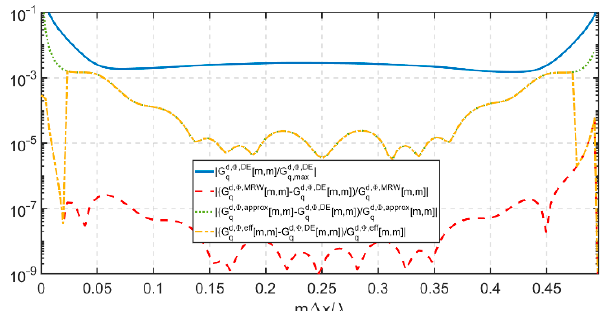
Figure 2. The solid line stands for values of the magnitude of G qd, Φ [m,m] normalized to maximum value computed by DE formulas. The dotted lines and dashed lines stand for the relative error of the values G qd, Φ [m,m] obtained by approximation given in Equation (28) and MRW quadrature rules with respect to the values obtained by DE formulas. The dash dotted lines stand for relative error for m = n obtained by mixed rules (MRW quadrature rules when m ∆ x / λ < 0.02 or (m ∆ x-a) / λ < 0.02, and approximation given in Equation (28) for the rest of the cases). We can see that the error level obtained by MRW quadrature rules is lower than 0.03% for the worst case (m = 0). The relative error of the results obtained by the approximation given in Equation (28) with respect to the results obtained by DE formulas is also shown as the dotted line. These errors reach values lower than 0.16% when m ∆ x / λ > 0.02 or ( m ∆ x-a) / λ > 0.02. However, the error level increases as m ∆ x / λ or ( m ∆ x-a) / λ decreases. Therefore, a mixed computation is implemented to obtain enough Φ accuracy: computation of G qd,A [ m,n ] and G qd, [ m,n ] by the approximations given by Equations